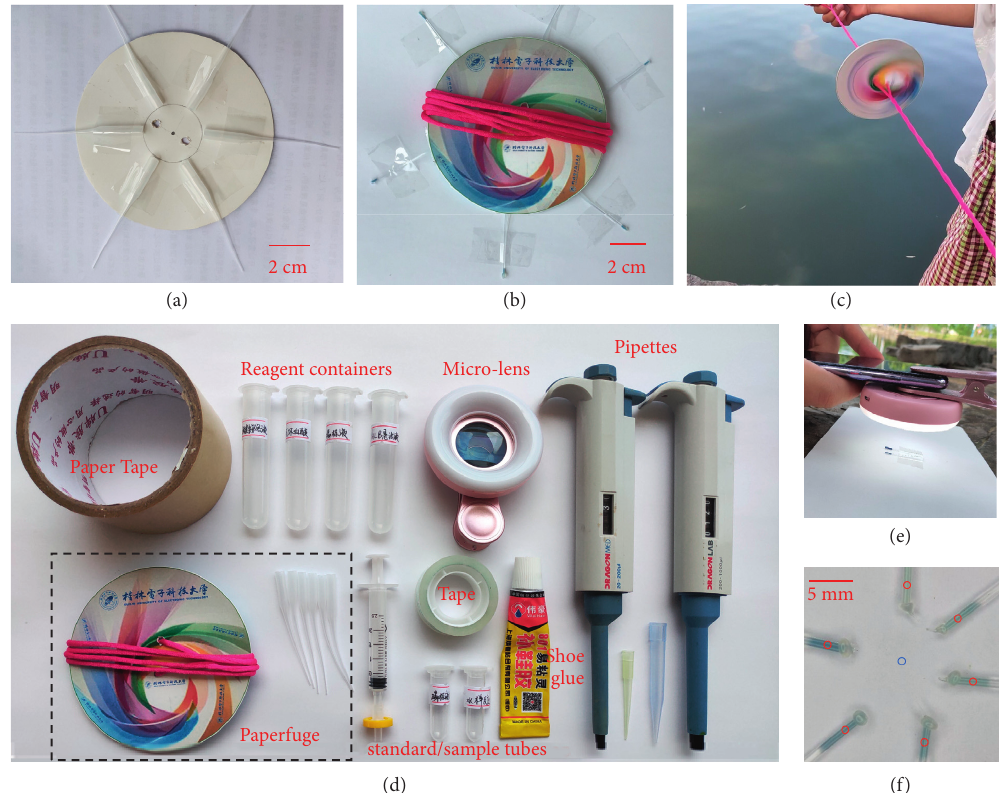
Figure 1: (a) Photo of taped six empty tubes on the paperfuge; (b) image of the paperfuge after preconcentrating phosphate; (c) spinning paperfuge; (d) materials required for field analysis by the PMB-SPE method; (e) capturing photo by a mobile phone equipped with a microlens; and (f) photo of six tube tips with preconcentrated PMB; cycles indicate the selected areas for analyzing color